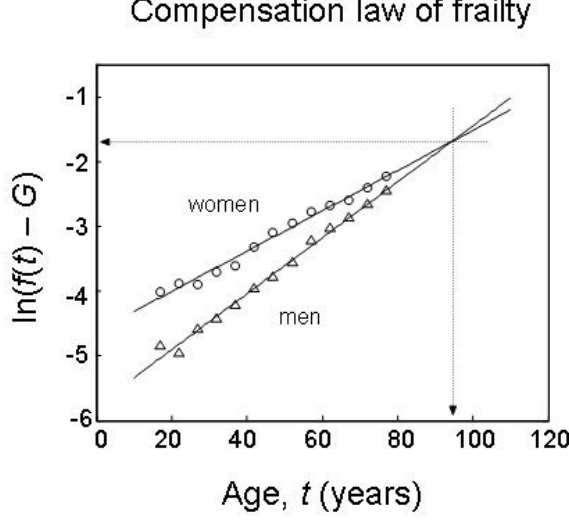
FIGURE 2 . The compensation law of frailty. Logarithm of age-dependent component of frailty for men and women. The least square lines have a cross-point corresponding to the 0.18 of the frailty index at age of 94 years, the same age parameter for the compensation law of